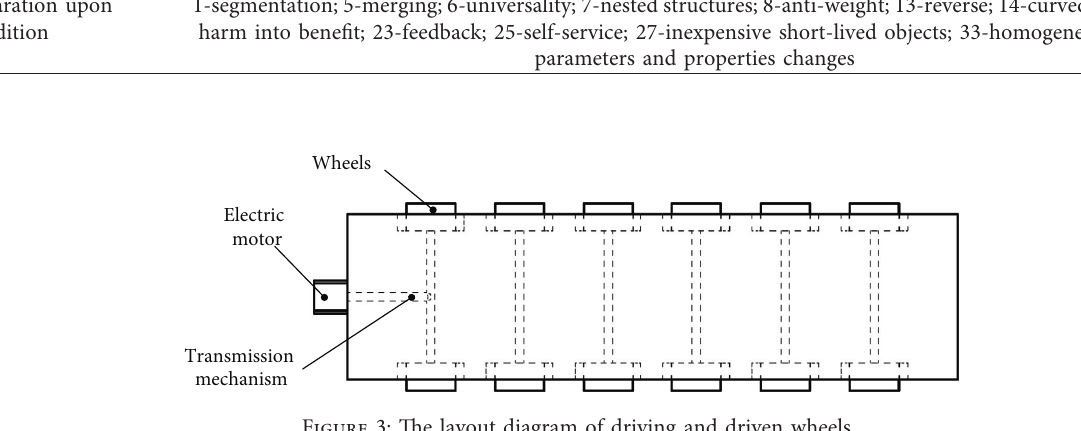
Inventive principles